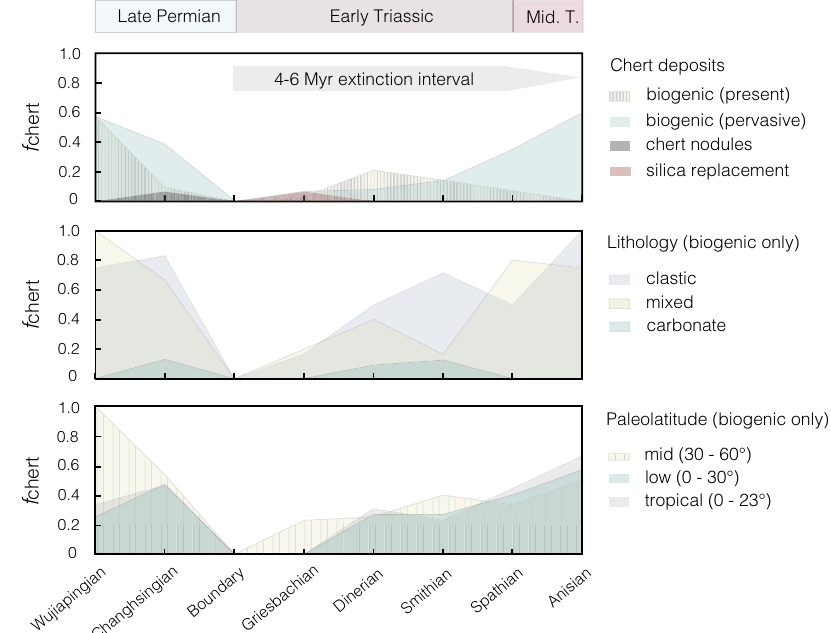
Fig. 4 The fraction of marine sedimentary sections bearing chert ( f chert ), spanning the Late Permian to Middle Triassic. The global compilation includes a total of 36 geographically disparate sites spanning a broad range of paleolatitudes (0 – 72°) (see Supplementary Fig. 1 and Supplementary Table 1). A Chert deposit types include biogenic (e.g., sponge spicules or radiolarian noted), nodules, and silica replacement. Biogenic chert deposits according to ( B ) lithology and ( C )